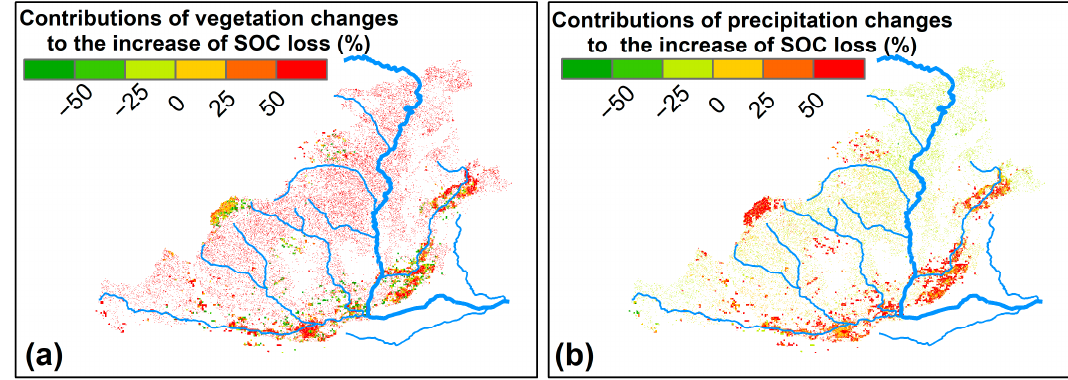
Figure 8. Contributions of ( a ) precipitation and ( b ) vegetation changes to the increase in SOC loss in regions with increasing SOC loss.